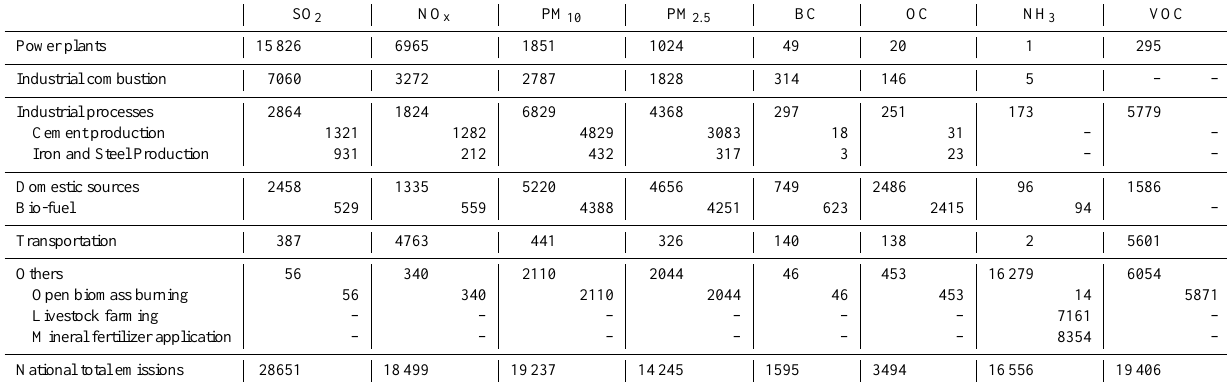
Table 1. Summary of National Emissions in China in 2005 (units, ktyr − 1